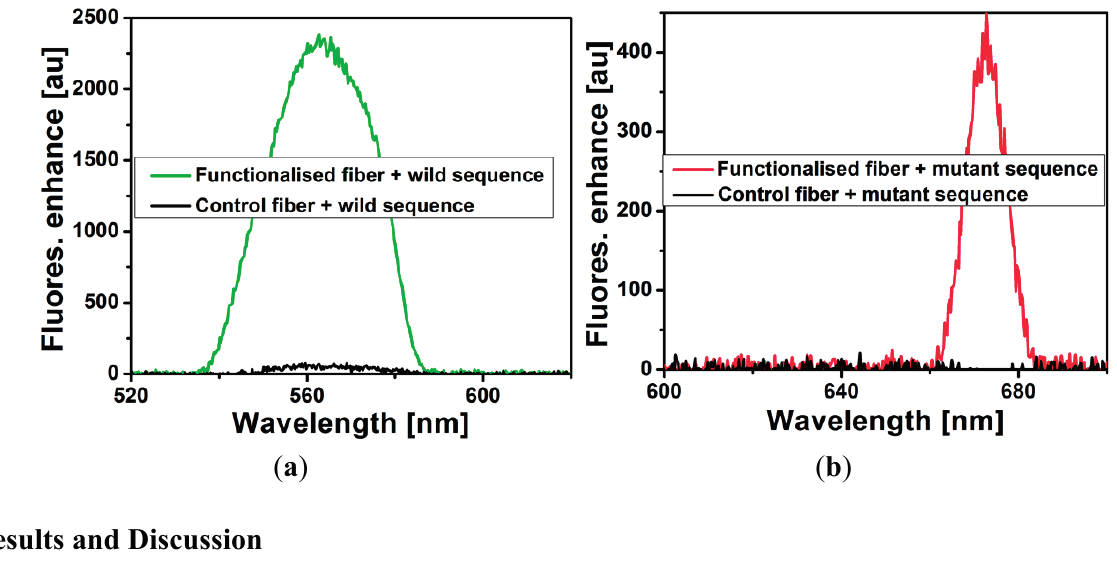
Figure 3. Comparison of fluorescence enhancement between dual-type MB immobilized SCF and control SCF upon filling with target DNA solution. The control SCF shows negligible fluorescence